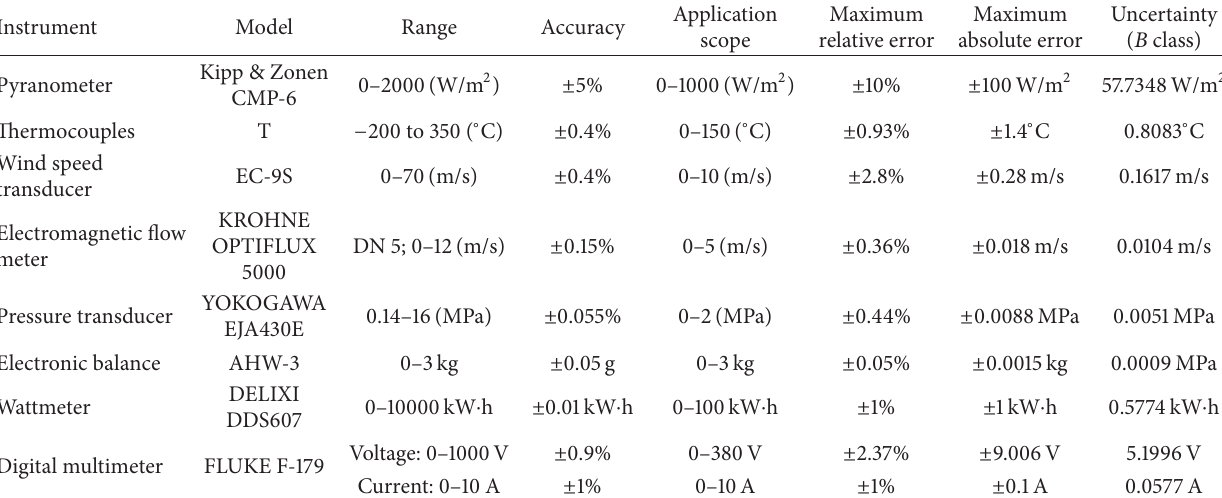
Table 2: Measuring instrument parameters and